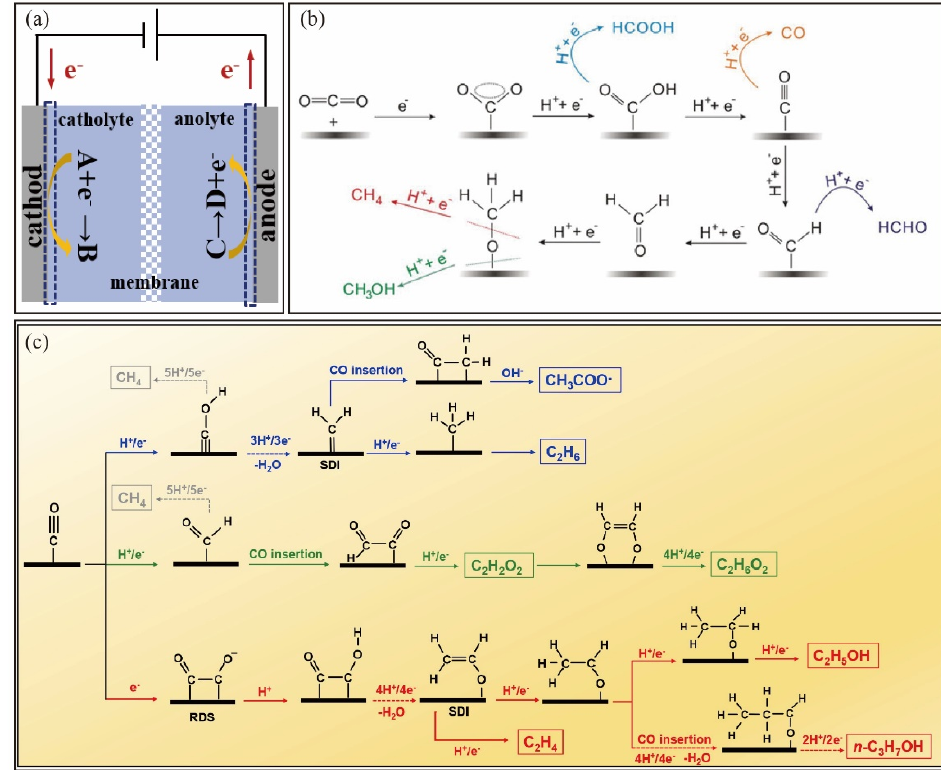
Figure 1. Electrocatalytic system and principle of CO 2 electrocatalytic reaction. ( a ) Model of a typical electrocatalytic system. Reprinted with permission from Ref. [28]. Copyright 2020, Elsevier. ( b ) Mechanism of CO 2 electrocatalytic reduction on electrodes in aqueous solutions. The formation paths of the five main C 1 products are illustrated during the reduction process. Reprinted with permission from Ref. [39]. Copyright 2017, John Wiley and Sons. ( c ) C 2 and C 3 pathways starting from *CO on Cu surfaces. Reprinted with permission from Ref. [40]. Copyright 2019, American Chemical Society.